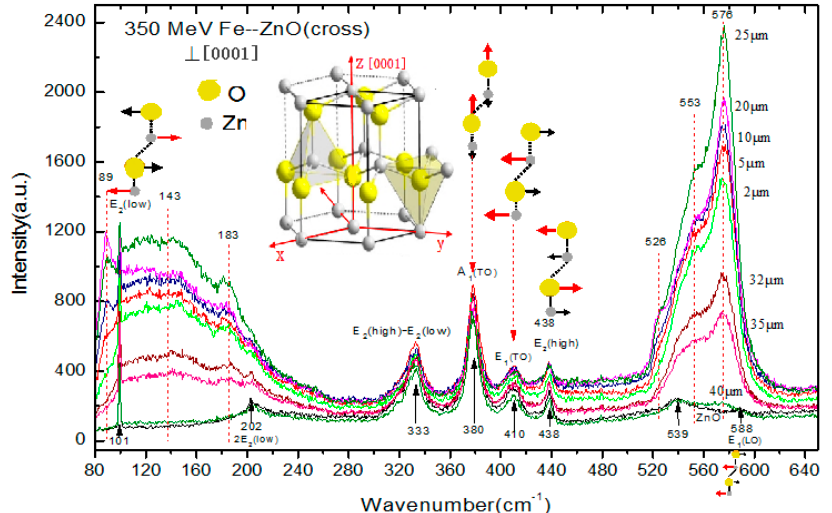
Figure 2. Raman spectra (incident light is perpendicular to the axis [0001]) of ZnO irradiated by 56 Fe 21+ ion with irradiation does of 1 × 10 14 ions / cm 2 . The incident ions were along [0001] of the crystal. The zinc oxide structure of wurtzite is shown in the image. The Raman peaks are described by corresponding atomic oscillations. (The motion of the dominant atom is indicated by the red arrows).